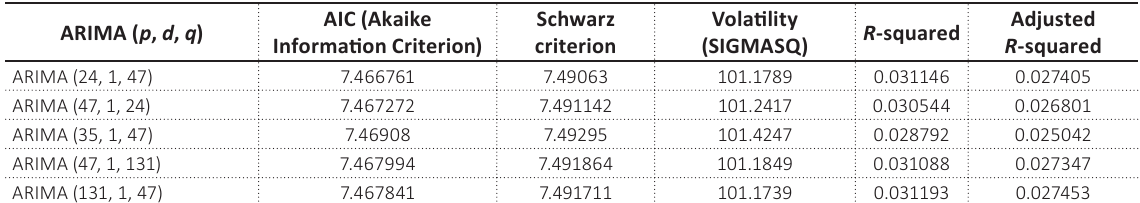
Table 1. The results of the best 5 ARIMA models out of 100 models for Sun Pharmaceutical Industries Ltd. AIC (Akaike ARIMA ( p , d , q ) Information